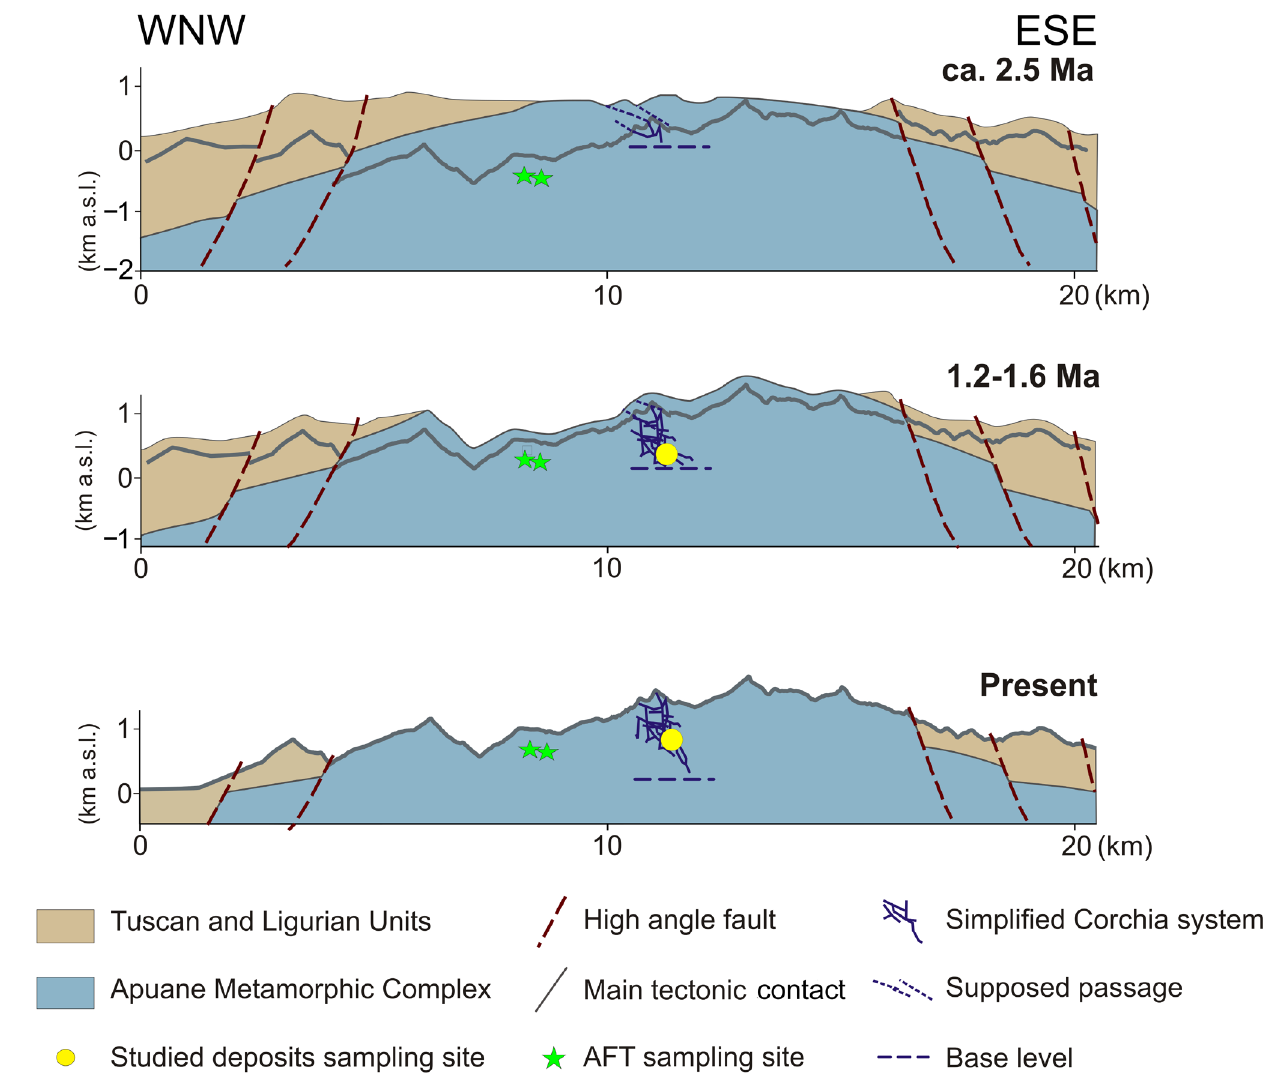
Figure 7. Schematic model showing the proposed chronology of the Corchia Cave system evolution and Alpi Apuane uplift over the last 2.5 Ma based on hypogean radiometric and paleomagnetic analyses and AFT thermochronology from the literature (Figure 1 and Table 2). 2.5 Ma: the highest of the sub-horizontal passages of the Corchia Cave system were already carved, while epigean streams sank and fed the sedimentary deposits with material eroded from metamorphic and non-metamorphic units. The AFT data locations are still buried at about 1.5 km depth. 1.2–1.6 Ma: the two higher karst levels of the Corchia Cave were completely developed, the lowest one was already carved near the base level, and the clastic infilling was occurring in the GdS. Present: the GdS is at about 870 m a.s.l., and a new phreatic level is forming around the modern base level.